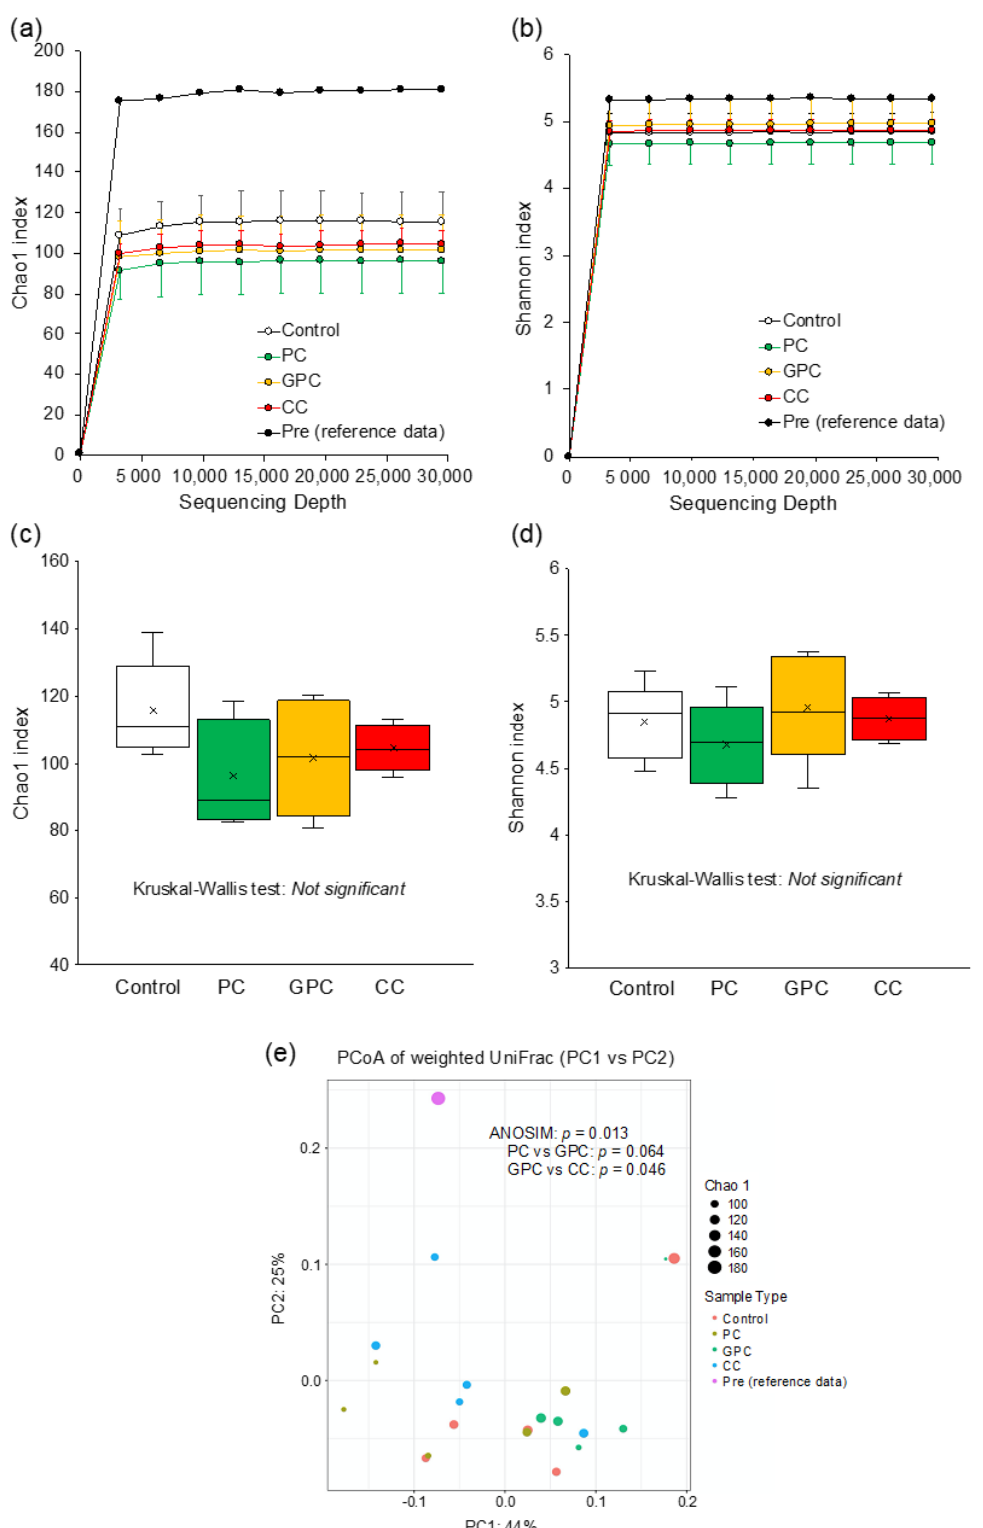
Figure 3. Effects of dietary choline compounds on diversity of fecal microbiota. ( a , b ) Bacterial rarefaction curves based on the α Chao 1 and Shannon diversity indices at the genus level, respectively. ( c , d ) Boxplots based on the α Chao 1 and Shannon diversity indices at the genus level, respectively. ( e ) Principal coordinate analysis (PCoA) based weighted UniFrac distance in β diversity at the genus level.